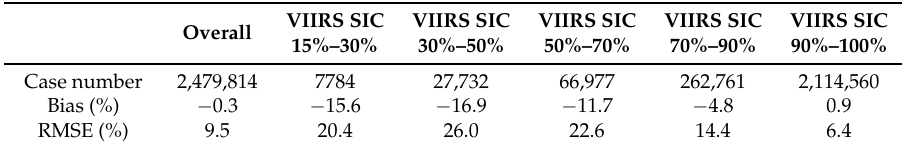
Figure 12. Comparison of VIIRS minus Landsat ice concentrations for different concentration ranges/bins. Note that for “All” and “90–100” plots the vertical axis range is different than for other sea ice concentration ranges. Table 5. Bias and RMSE with bias removed (precision) for comparisons of VIIRS minus Landsat ice concentrations for different concentration ranges/bins.